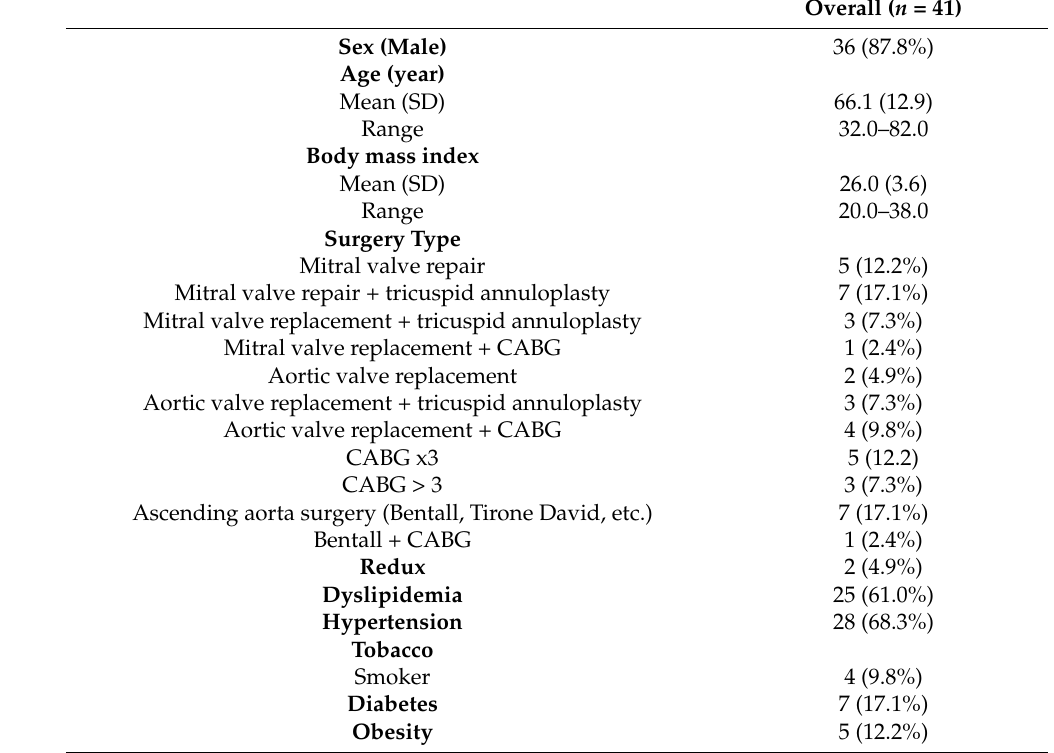
Table 2. Description of demographics and clinical data from the